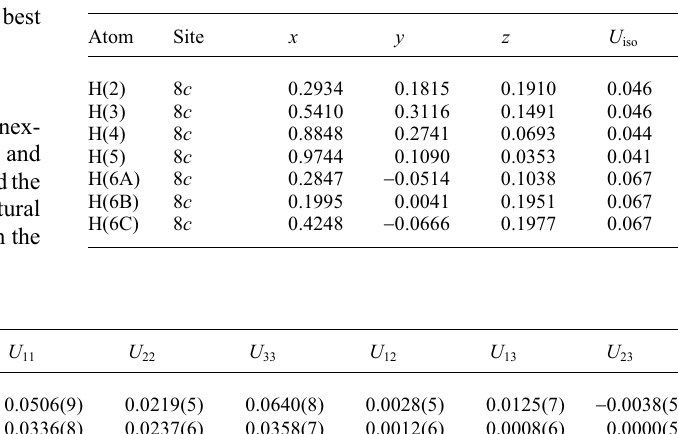
Table 2. Atomic coordinates and displacement parameters (in Å 2 ) .